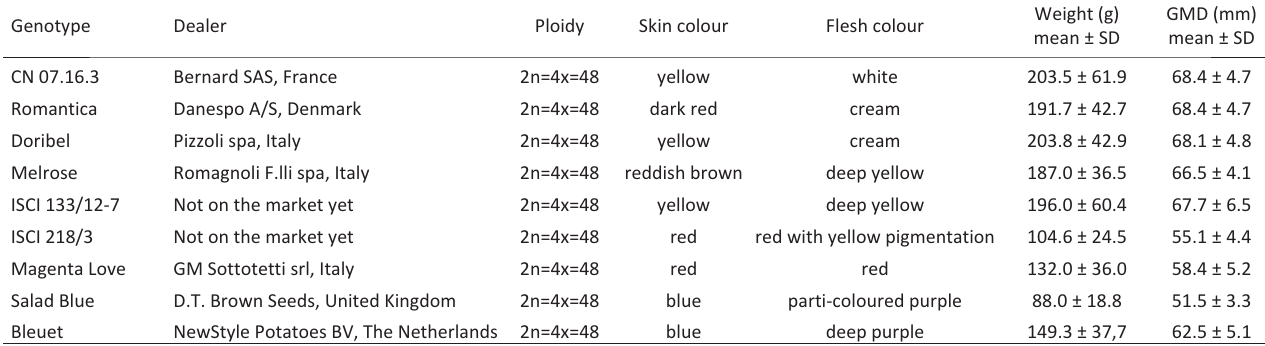
Table 1 ­ Potato genotype